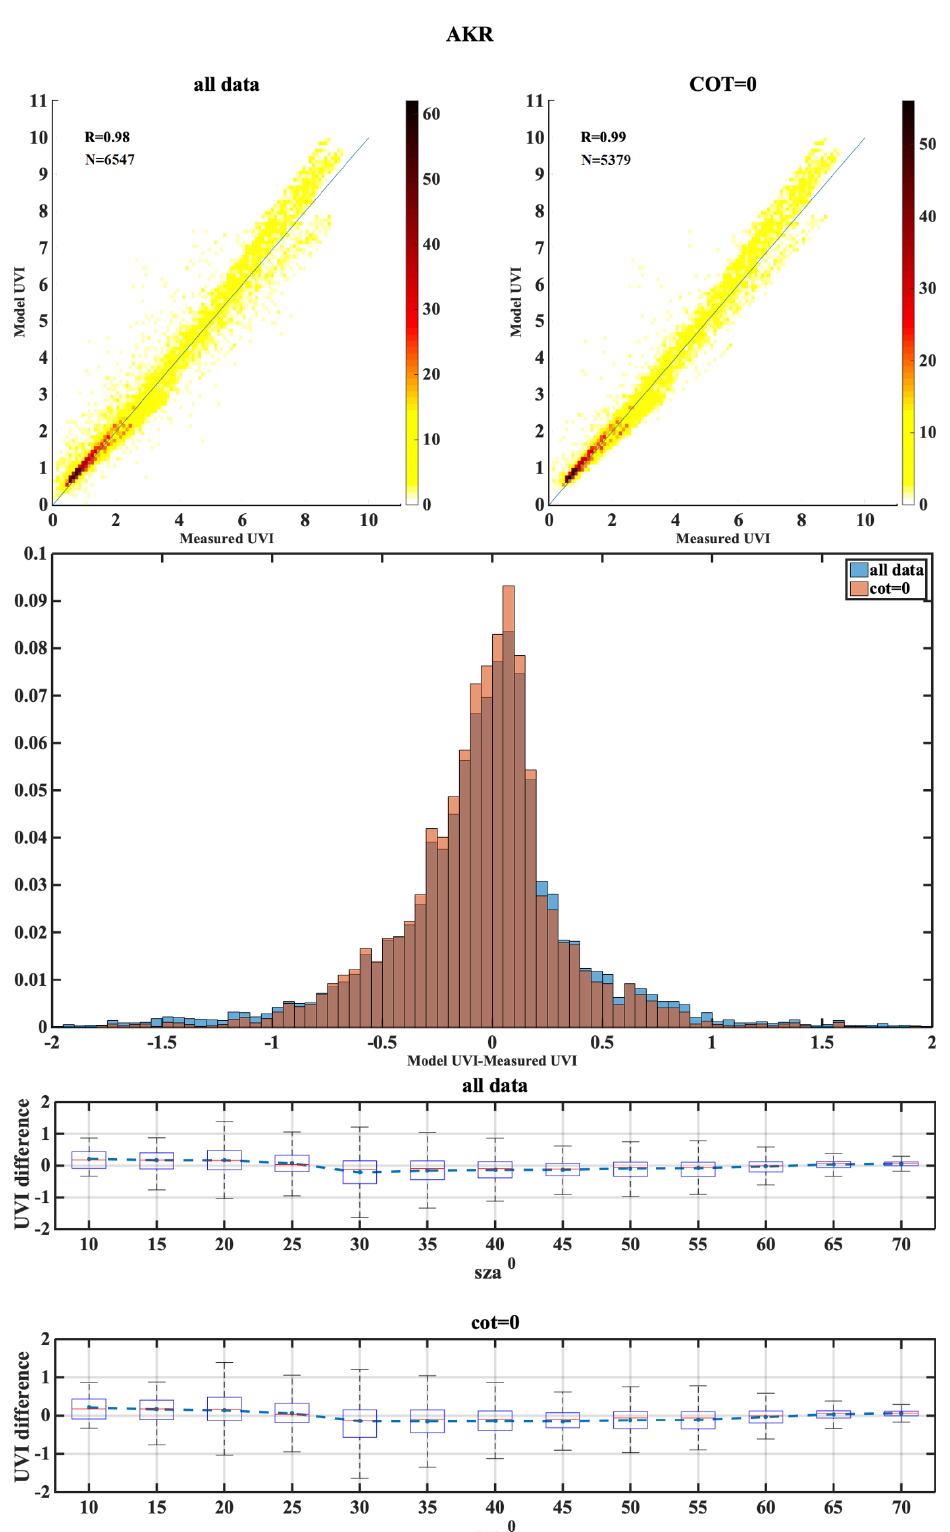
Figure A1. Density scatterplots of measured and modeled UVI for all-sky and clear-sky conditions (upper row) for the AKR station, nor- malized probability histogram of differences (middle row) and boxplot of differences as a function of SZA (lower row).